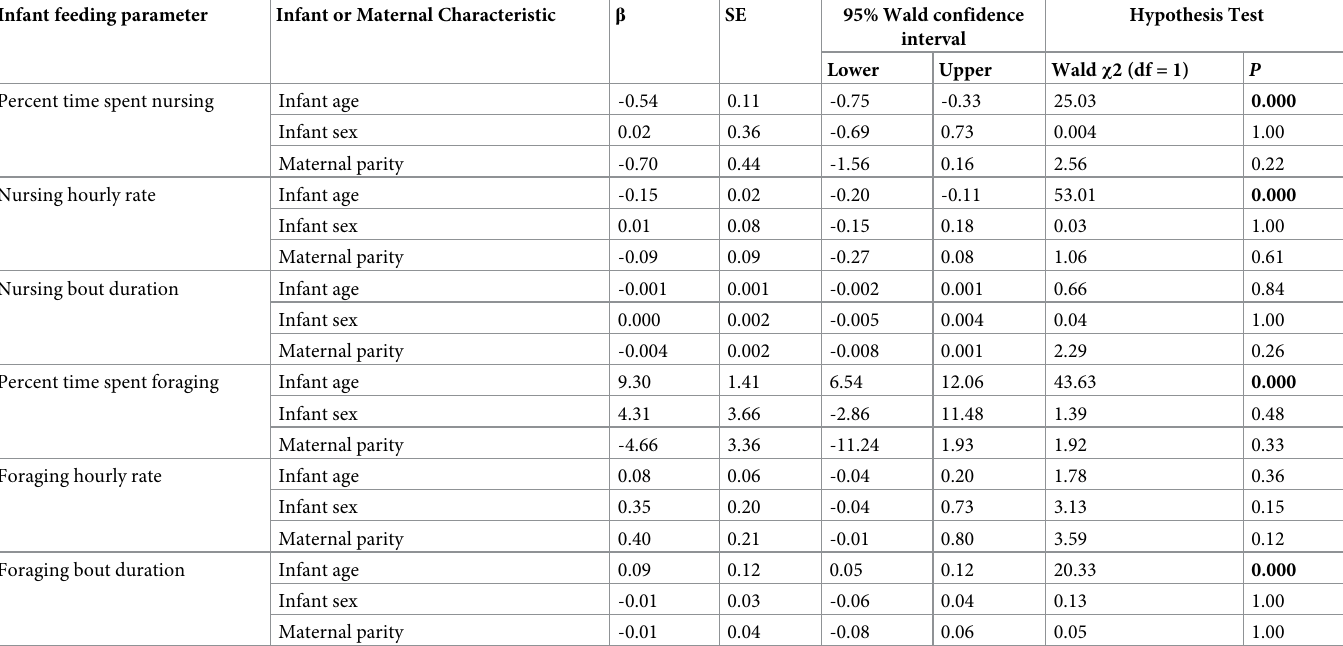
Table 2. Generalized Estimating Equations (GEEs) for correlations between feeding parameters of chimpanzees 0 to 9 years old and infant age, sex, and maternal parity.